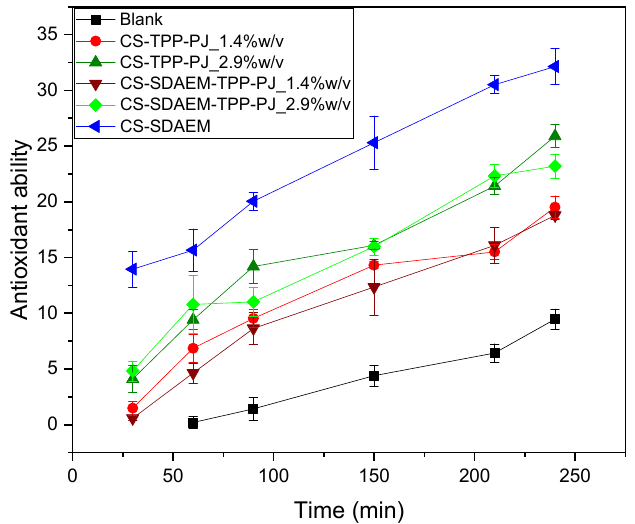
Figure 12. Study of the kinetic of the antioxidant ability of emulsions during the first 4 h.